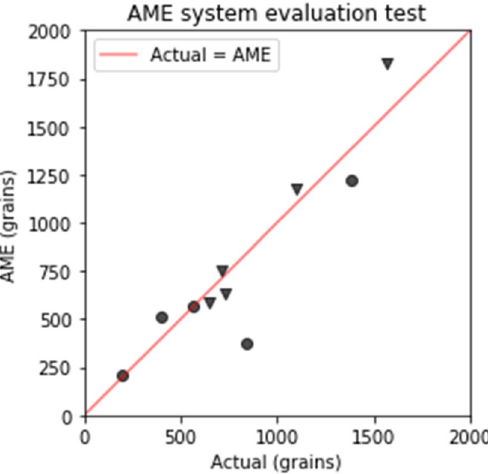
Figure 5. Results of five tests (circle: Chamaecyparis obtusa , triangle: Cryptomeria japonica . The red line represents the line on which the actual data and the estimation by the AME system are the same.